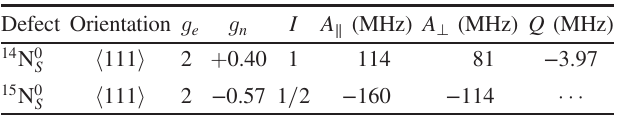
TABLE I. Spin parameters of N 0 taken from Ref. [59]: ori- S entation of defect structure or principal hyperfine axis, electronic g factor, nuclear spin of isotope, and magnetic ( A ∥ , A ⊥ ) and electric ( Q ) hyperfine parameters. Defect Orientation g